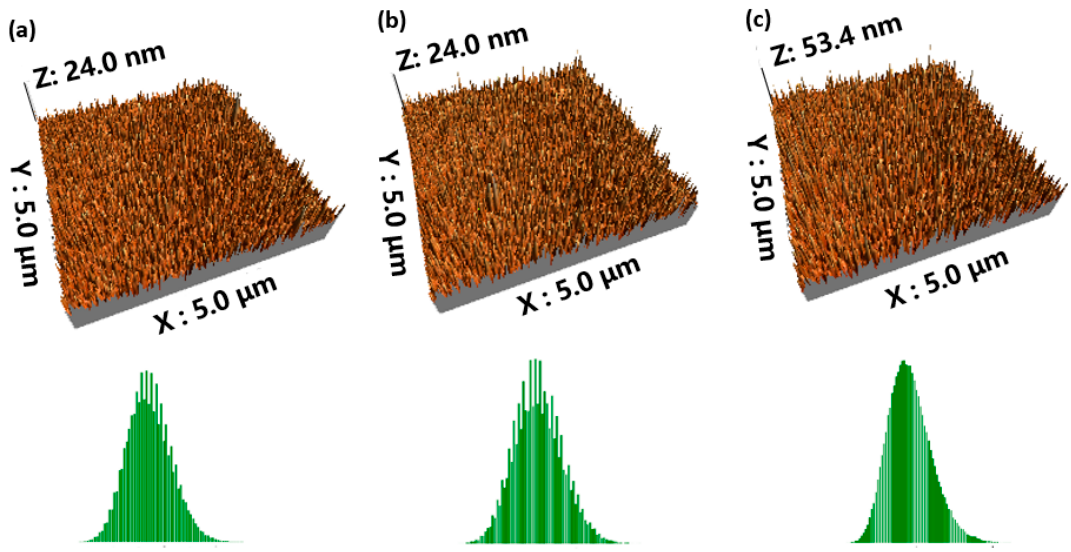
Figure 5. The AFM image of the IGZO. ( a ) 25% − Ar 75% − O 2 ; ( b ) 50% − Ar 50% − O 2 ; ( c ) 100% − Ar; The lower row: high peak probability distribution.